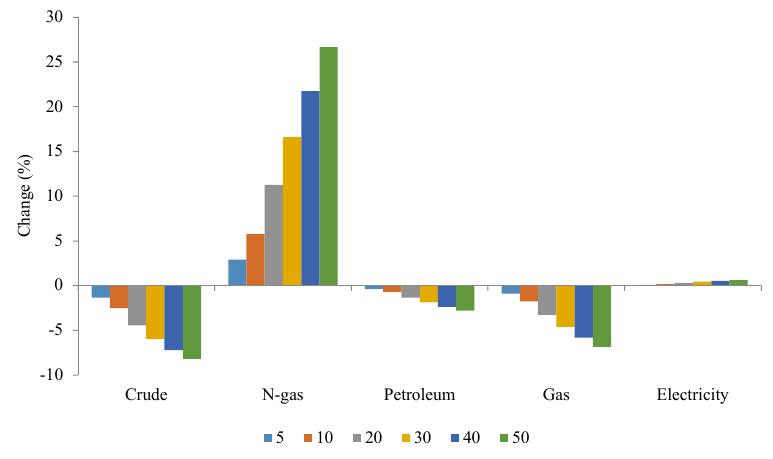
Fig. 9: Demand change of energy commodities due to different carbon tax (5 to 50 $ per ton of CO 2 ) Table 3: Sensitivity analysis: the effects of environmental policies on selected variables: Per cent changes from benchmark value (the case of 10% and 20% carbon reduction)